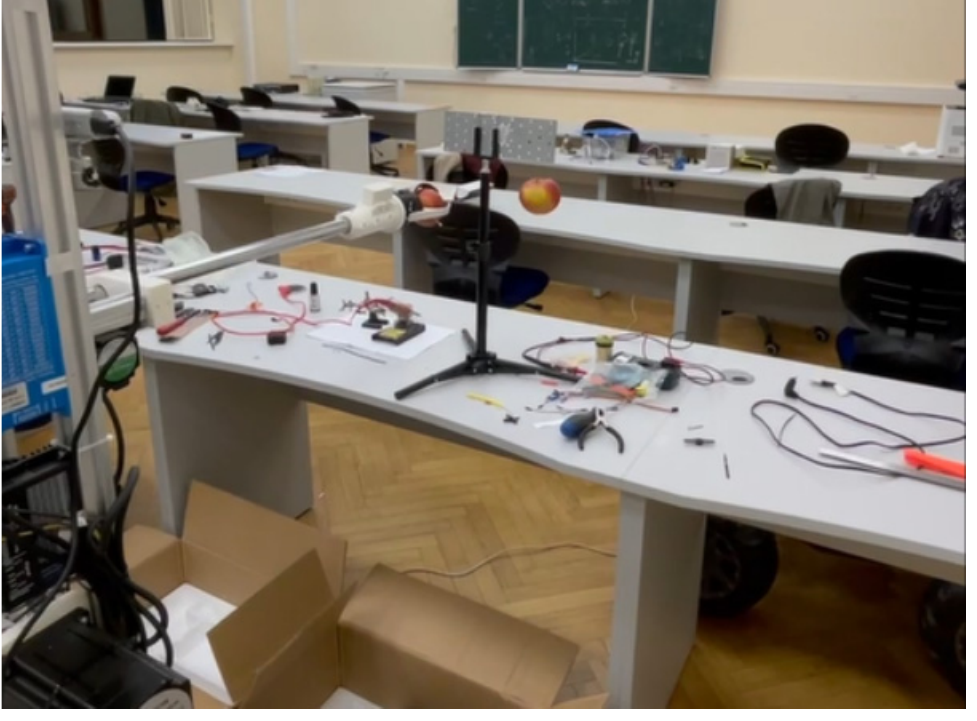
Table 5. Movement politics